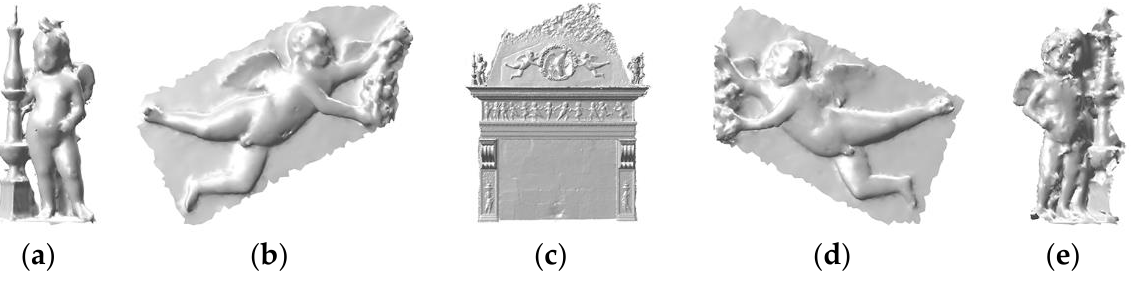
Figure 2. Render of the input 3D models: ( a ) angelo-1L.obj, ( b ) angelo-2L.obj, ( c ) camino degli angeli.obj, ( d ) angelo-2R.obj, ( e ) angelo-1R.obj.